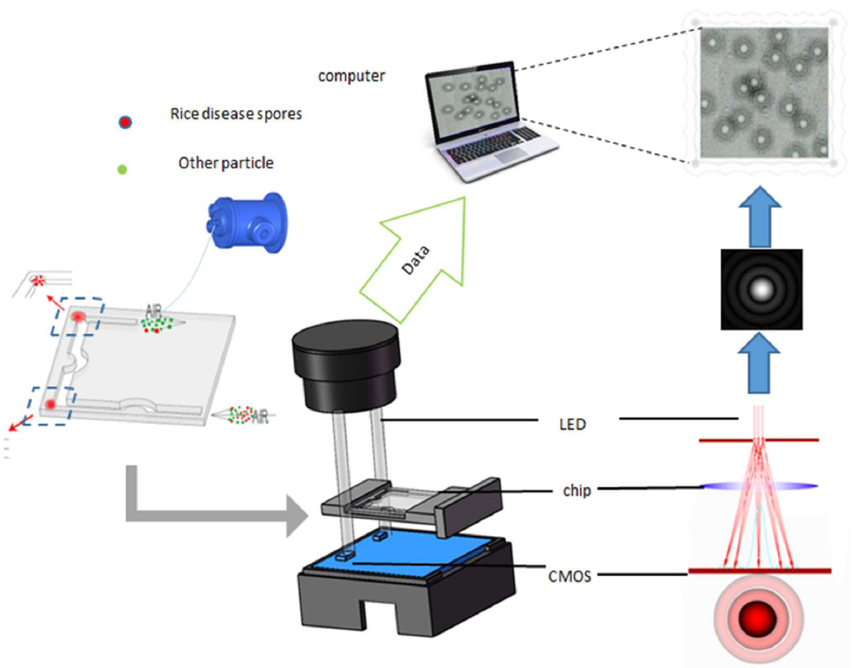
Figure 2. Portable real-time rice disease spores detection using characteristics of diffraction fingerprints on the microfluidic chip.